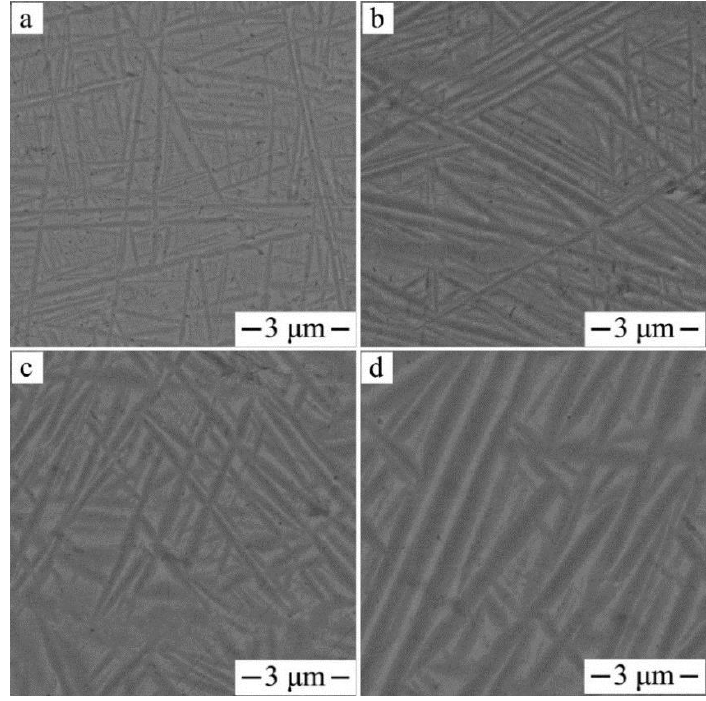
Figure 14. SEM, backscattered electron images of the Ti6Al4V30Zr alloy after solution treated at 820 °C and aged at different temperatures: ( a ) 500 °C ; ( b ) 550 °C ; ( c ) 600 °C ; ( d ) 650 °C .